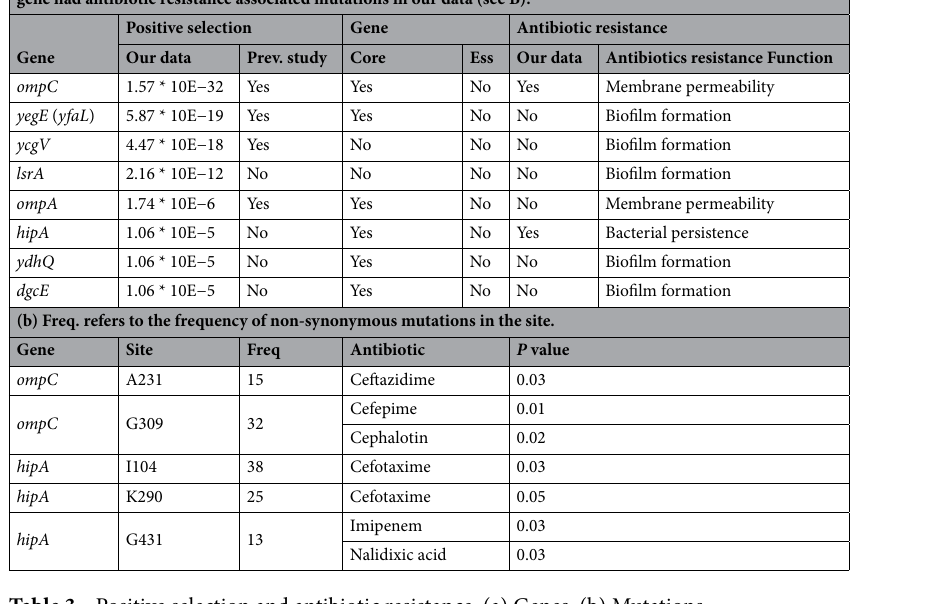
Table 3. Positive selection and antibiotic resistance. (a) Genes. (b) Mutations.